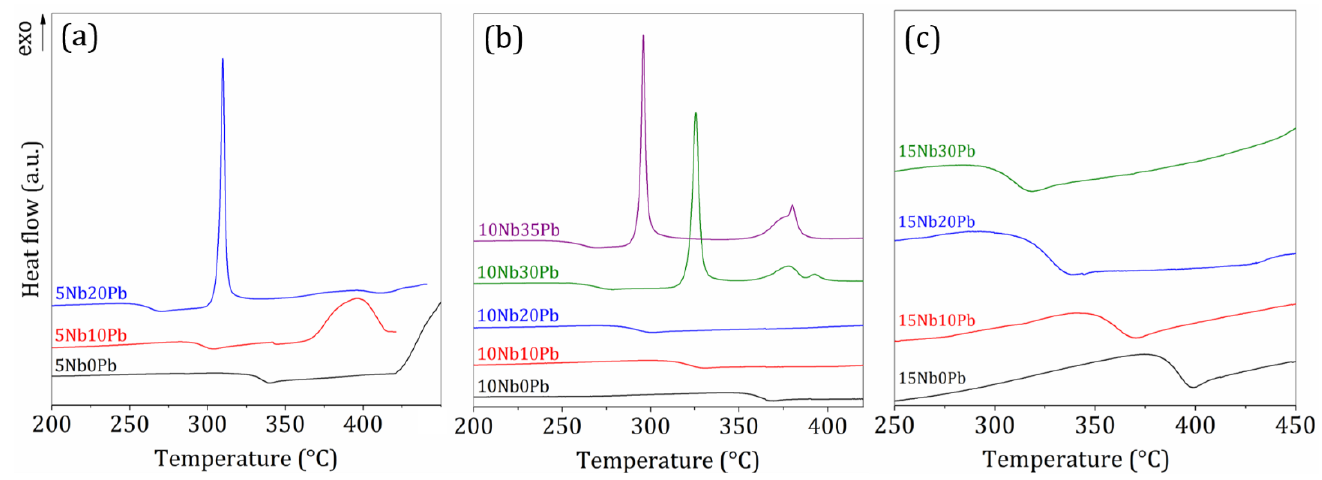
Figure 2. DSC curves of glasses in the glass series ( a ) 5NbyPb, ( b ) 10NbyPb and ( c ) 15NbyPb. These thermal results highlight the opposite intermediary and modifier behaviors of Nb 2 O 5 and PbF 2 on the tellurite glass network since niobium insertion